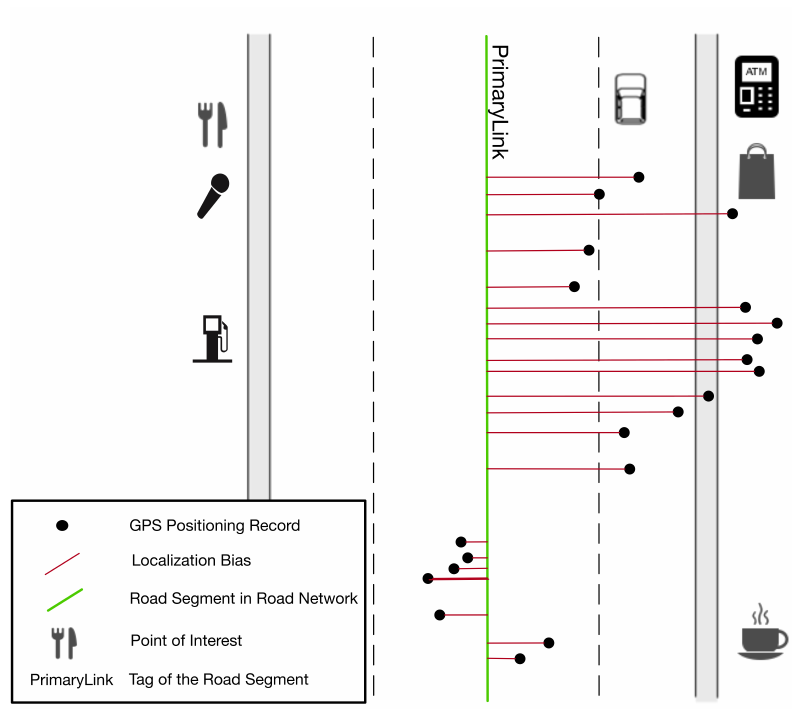
Figure 2. Meta information of the data.